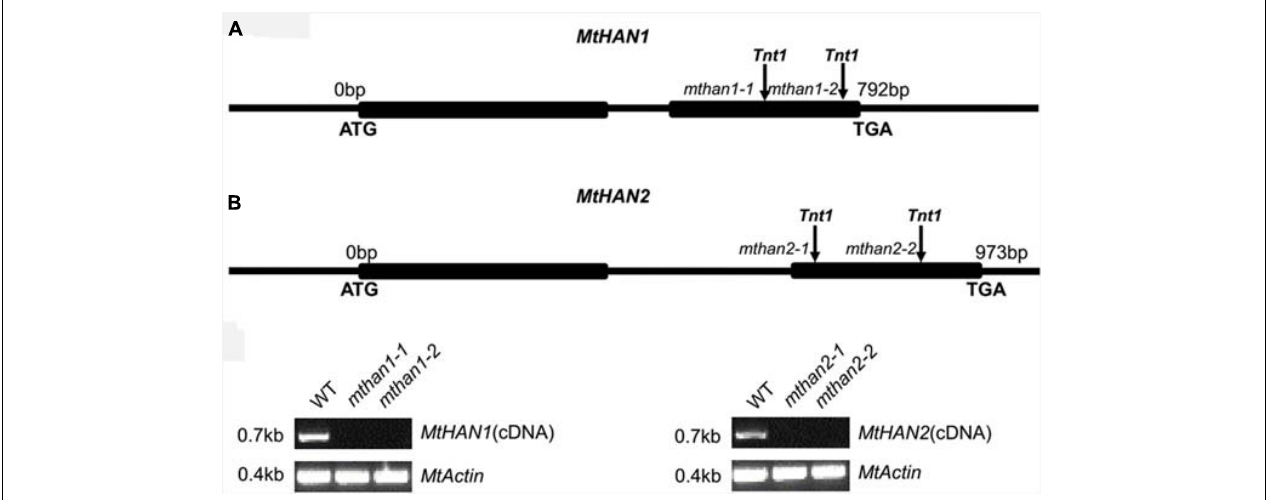
FIGURE 2 | Molecular characterization of MtHANs in M. truncatula . (A) Schematic diagram of the gene structure of MtHAN1 and MtHAN2 . Vertical arrows mark the positions of the Tnt1 insertions. Boxes represent exons and lines represent introns and UTRs. (B) RT-PCR analysis of MtHAN1 and MtHAN2 transcripts in the wild type (WT) and mutant alleles. MtActin was used as a loading control. 28 cycles were used for the RT-PCR.